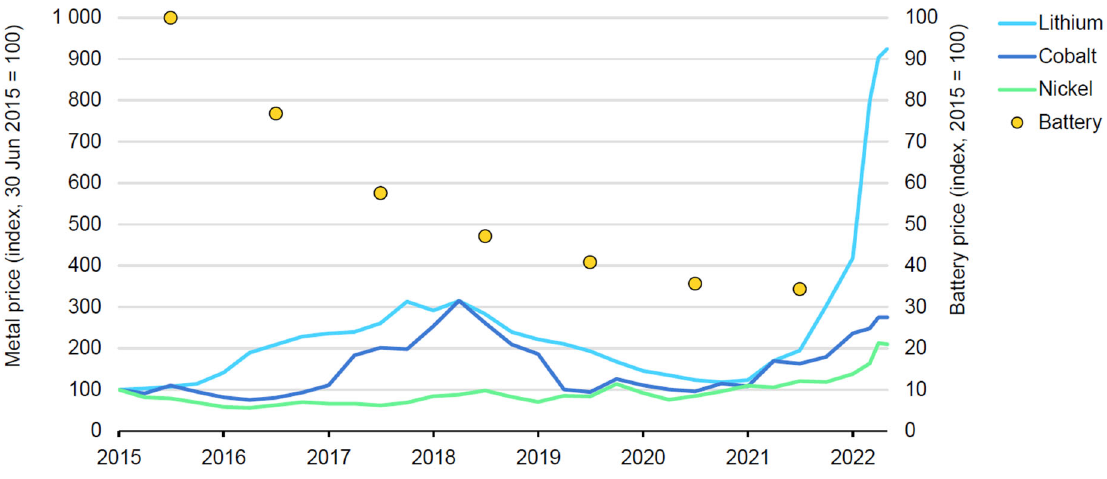
Figure 2. Battery metals prices from 2015 to May 2022 reprinted with permission from [3].